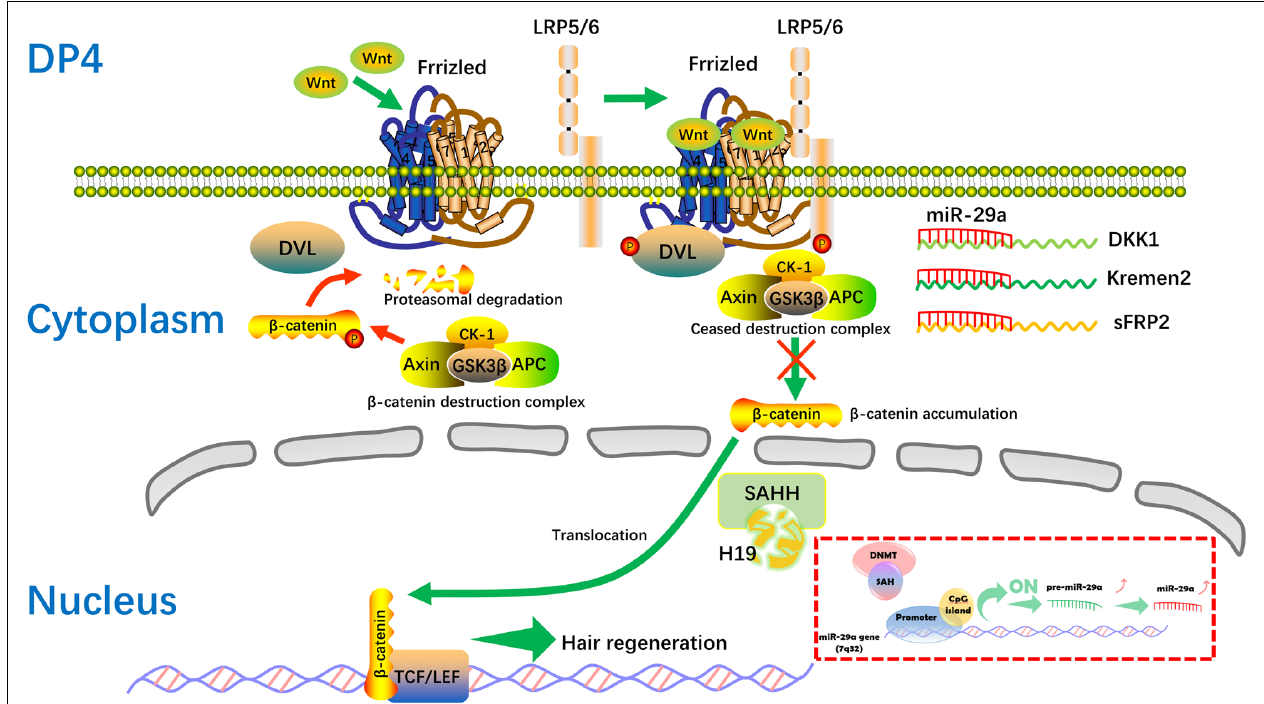
FIGURE 7 | Hypothetical molecular mechanism of the H19/miR-29a/Wnt signaling pathway in HF inducibility of DP cells. When H19 is overexpressed, SAHH activity is attenuated, leading to accumulation of SAH, which binds to DNMT and prevents it from methylating DNA. MiR-29a directly suppresses the expression of Dkk1, Kremen2, and sFRP2, which act as suppressors of the Wnt pathway, thereby forming a novel regulatory feedback loop between H19 and miR-29a to mediate HF regeneration. SAH, S-adenosylhomocysteine; SAHH, S-adenosylhomocysteine hydrolase.